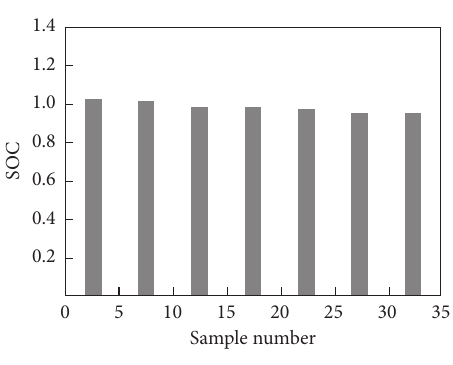
Figure 13: Measured SOC.